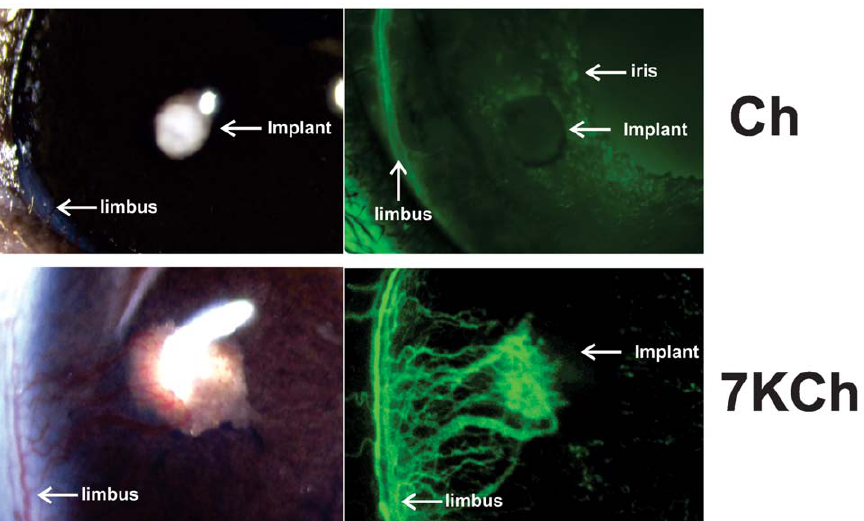
Figure 2. Angiogenesis in Ch versus 7KCh implants. Ch (20% w/w) and 7KCh (10% w/w) implants were placed in the anterior chamber of the rat eye as described in Fig. 1. Both implants were imaged 7 days post implantation with and without fluorescein angiography. Arrows mark the locations of the iris, limbus and implants.